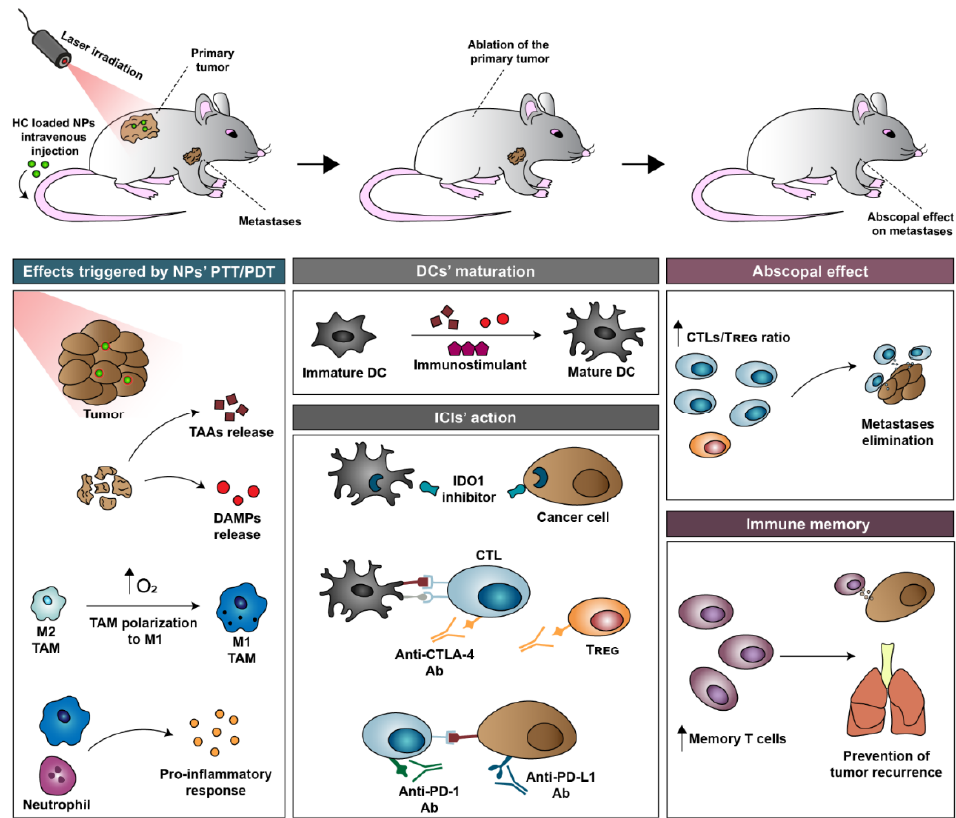
Figure 2. Schematic representation of the different events occurring during the immuno-PTT/PDT mediated by HC-loaded nanoparticles. In this process, the nanoparticles are generally administered intravenously. The immunostimulants and the ICIs can be administered in conjugation with the nanoparticles or at a later time point. After nanoparticle administration, the primary tumor is irradiated with NIR light. The nanoparticles’ photothermal/photodynamic effects can per se induced damage in the primary tumor and can also trigger (i) TAAs/DAMPs release, (ii) hypoxia relief, and (iii) a pro-inflammatory response. The released TAAs can then be processed, leading to DC maturation. DC maturation is also aided by the DAMPs and by the immunostimulants.